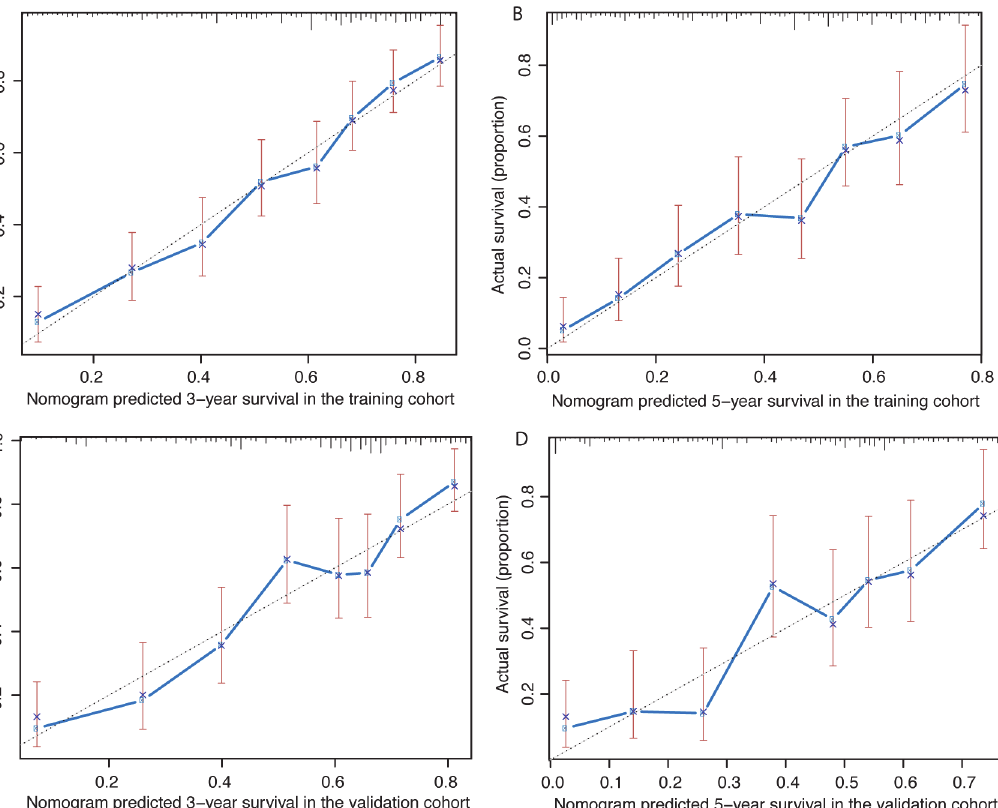
Fig 2. Calibration curve of the nomogram model. The X-axis and Y-axis represent the nomogram-predicted and actual survival probabilities, respectively. (A) Three-year and (B) Five-year overall survival in the training cohort. (C) Three-year and (D) Five-year overall survival in the validation